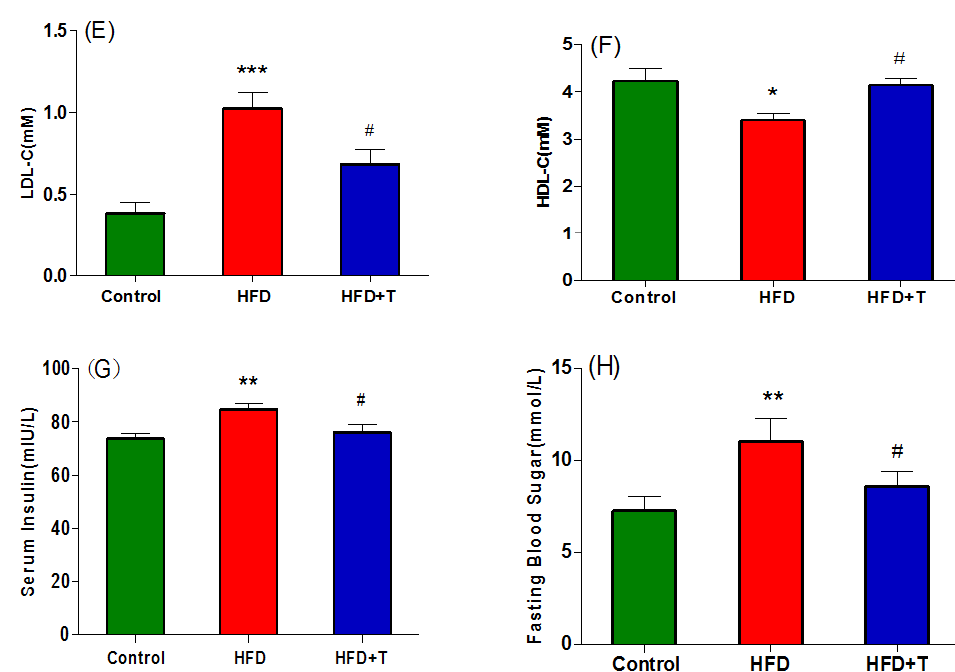
Figure 1. Phenotypical properties of mice in control group, HFD group and HFD-T group including ( A ) bodyweight, ( B ) energy intake, ( C ) serum TG, ( D ) serum TC, ( E ) serum LDL-C, ( F ) serum HDL-c, ( G ) fasting insulin, ( H ) fasting blood glucose TG. * p < 0.05, ** p < 0.01, *** p < 0.001 vs. group Control; # p < 0.05 vs. group HFD.